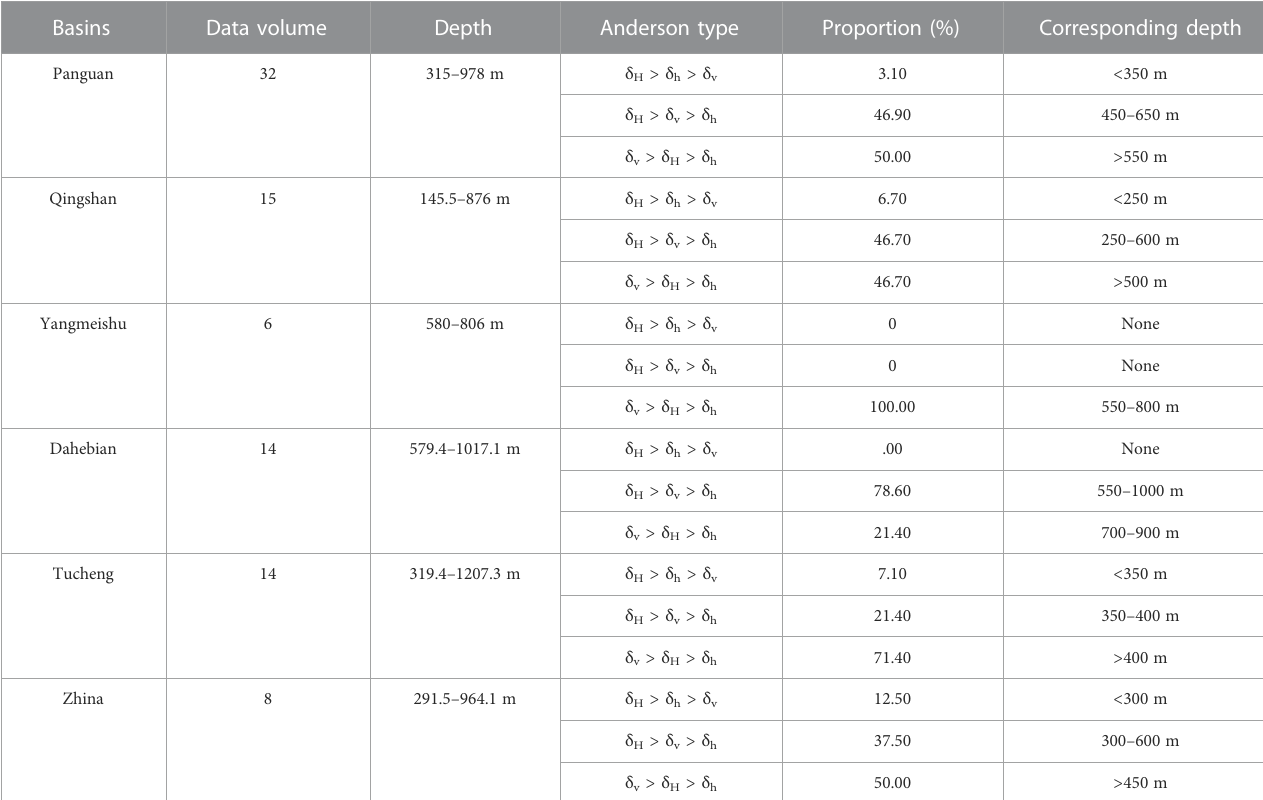
TABLE 2 In situ stress distribution in different coal bearing basins in western Guizhou.